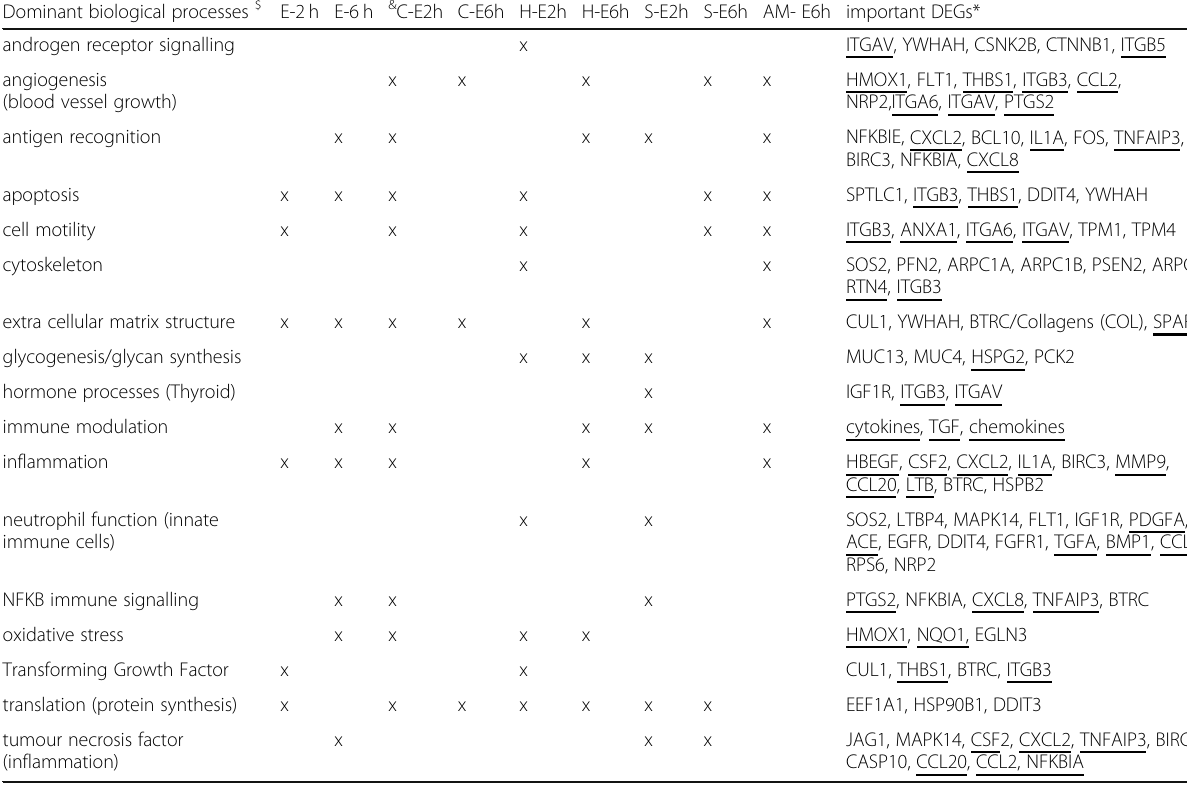
Table 4 Dominant biological processes regulated by algae extracts in the presence of ETEC Dominant biological processes $ E-2 h E-6 h & C-E2h C-E6h H-E2h H-E6h S-E2h S-E6h AM- E6h important DEGs* androgen receptor signalling